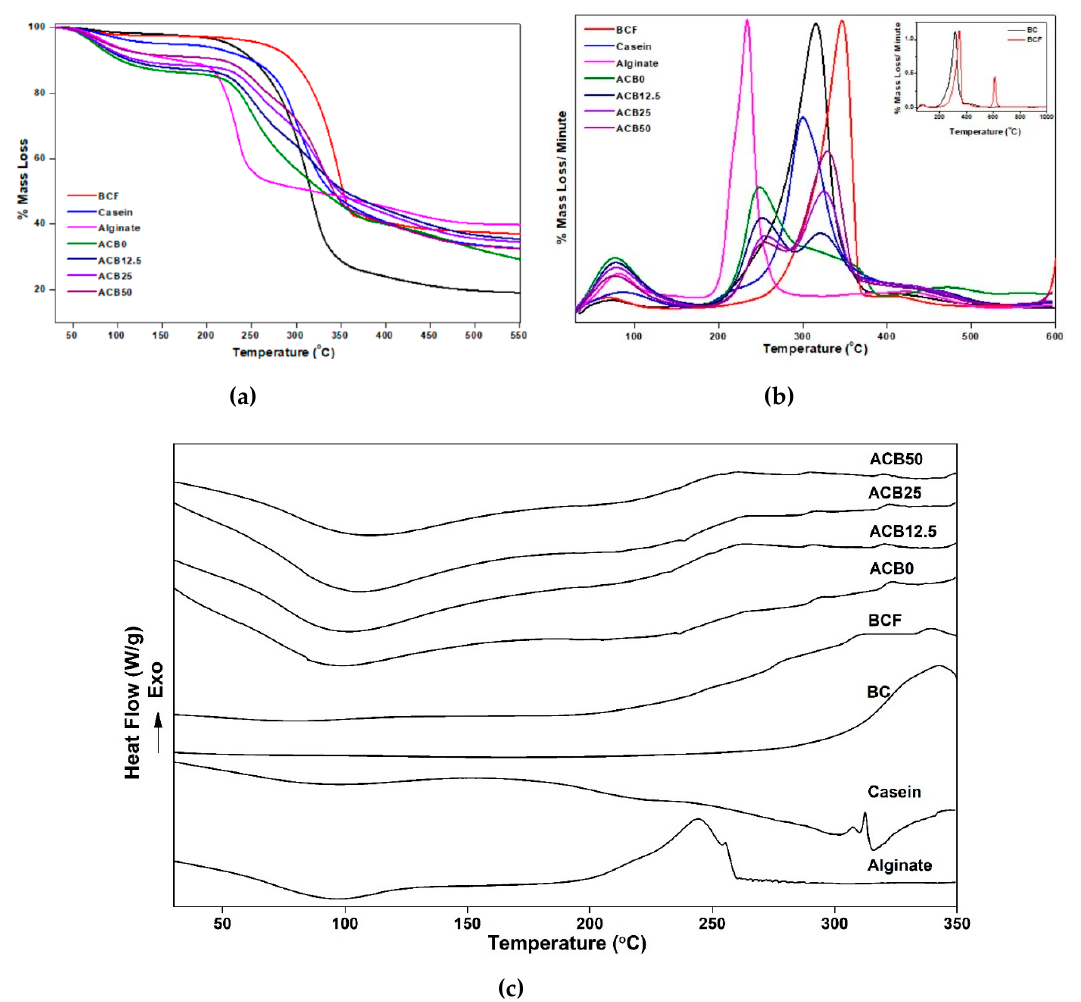
Figure 6. ( a ) Thermogravimetric (TG), ( b ) derivative TG and ( c ) DSC temperature profiles for alginate, casein, BC, BCF and ACB